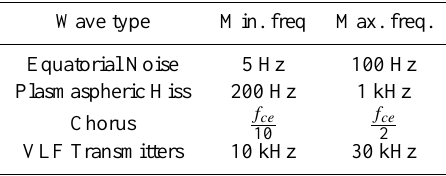
Table 1. Frequency bands defined to estimate wave